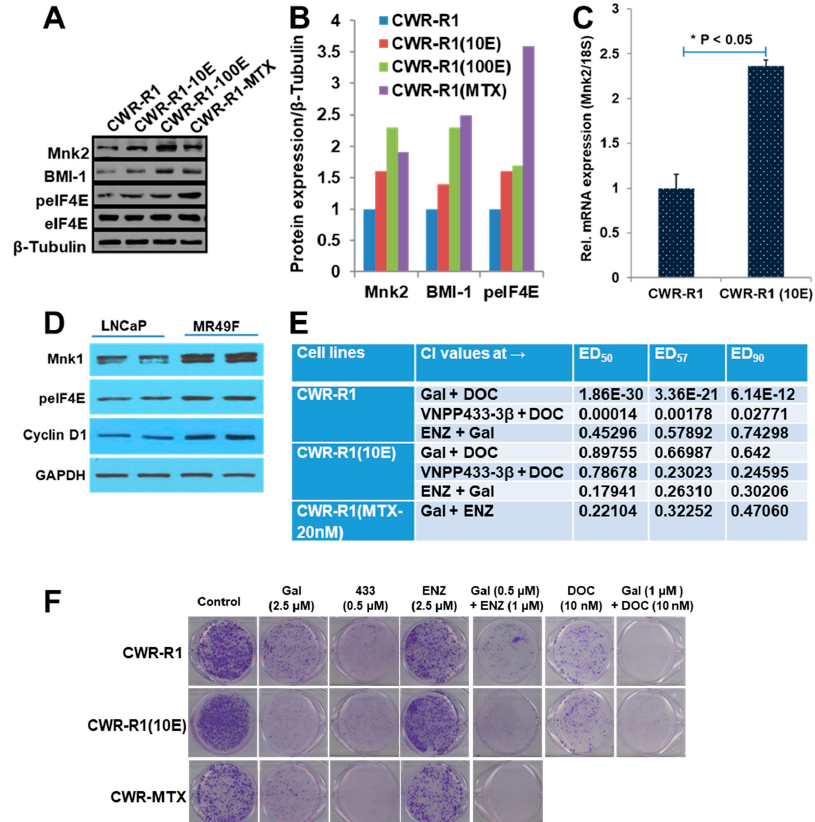
Figure 3. Characterization of drug-naïve/-resistant prostate cancer cells and effects of drug combinations with Gal or VNPP433-3 β . ( A ) Western blot of protein expressions in CWR-R1, CWR-R1, (10E) and CWR-R1 (MTX-20nM) cells. ( B ) Densitometry of three representative experiments were averaged and plotted as bar charts. ( C ) Mnk2 mRNA expression in CWR-R1 and CWR-R1 (10E). ( D ) Western blot analysis of Mnk1, peIF4E, and cyclin D1 in LNCaP and ENZ-resistant MR49F cells. ( E ) Combination indices of agent interactions in prostate cancer cell lines. Cell viability assays were conducted for Gal, VNPP433-3 β , ENZ, and docetaxel (DOC) individually and GI 50 values calculated. Compounds were subsequently combined at their GI 50 (constant ratio). Fractional e ff ects of single agents and in combination were calculated and analyzed by Calcusyn software to compute the combination indices (CI) at ED 50 , ED 75 , and ED 90 . (CI < 1 -synergy, CI = 1 -additive and CI > 1 -antagonism) as previously described [9,10]. ( F ) Representative photographs of colonies formed in cells at 14 th day after initial treatment with the indicated compounds. Colonies were fixed with methanol and stained with crystal